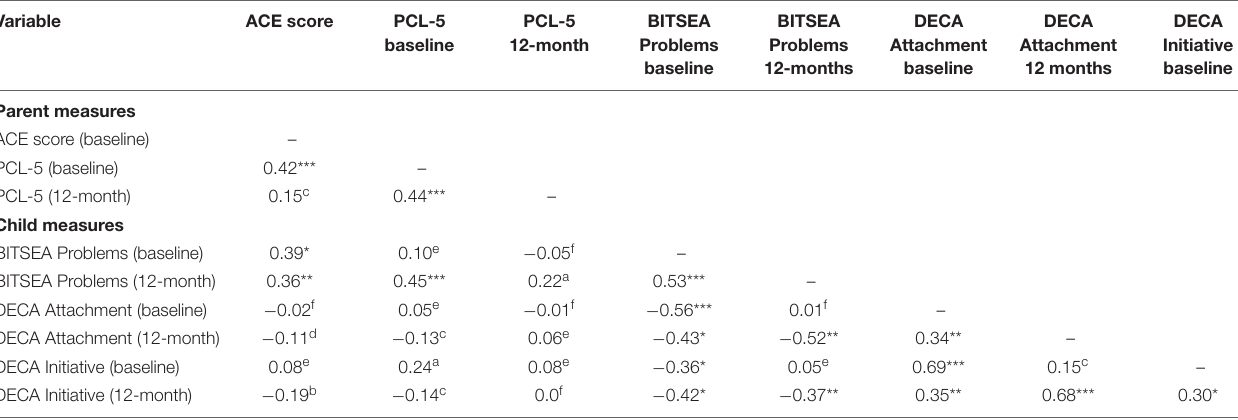
TABLE 3 | Correlations among key study variables.